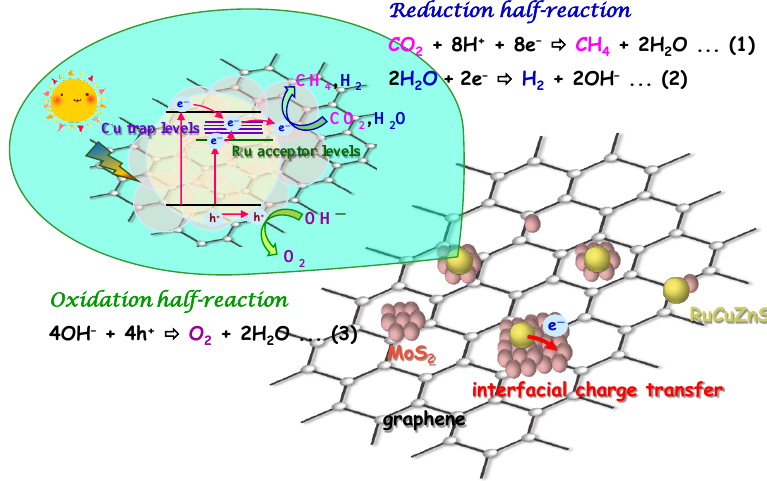
Figure 6. The photocatalytic CO 2 reduction mechanism over 0.5RCZS/MSG heterostructured photocatalysts.